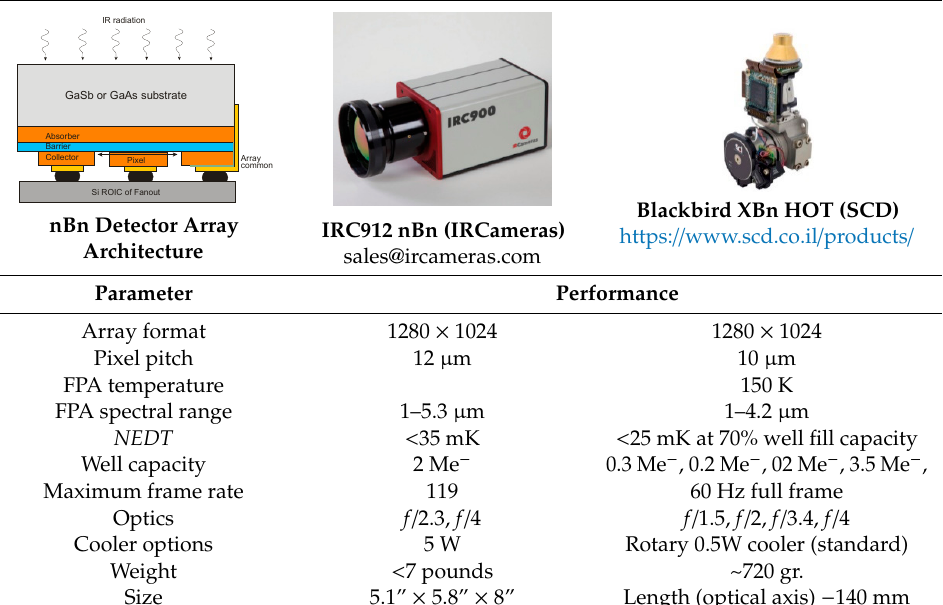
Table 6. nBn InAsSb FPA characteristics.